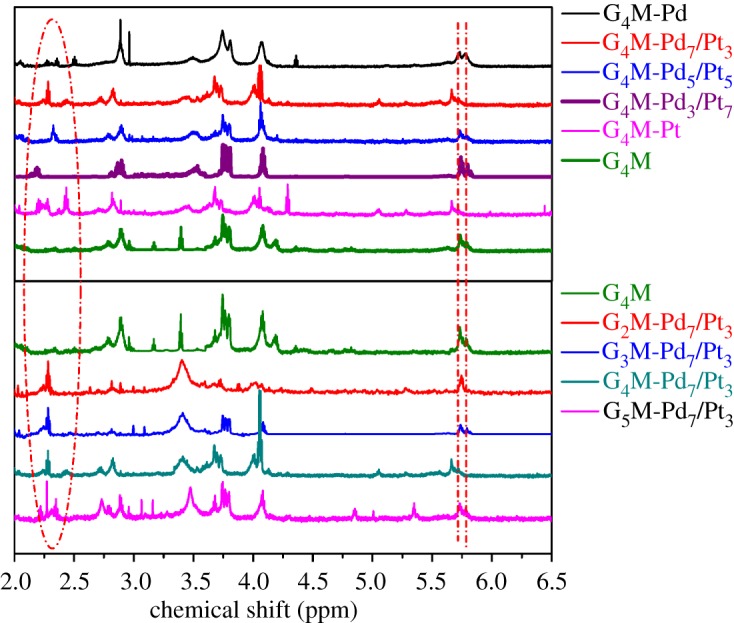
1H NMR spectra of GnM and GnM-(Pdx/Pt10−x) (n = 2, 3, 4, 5).